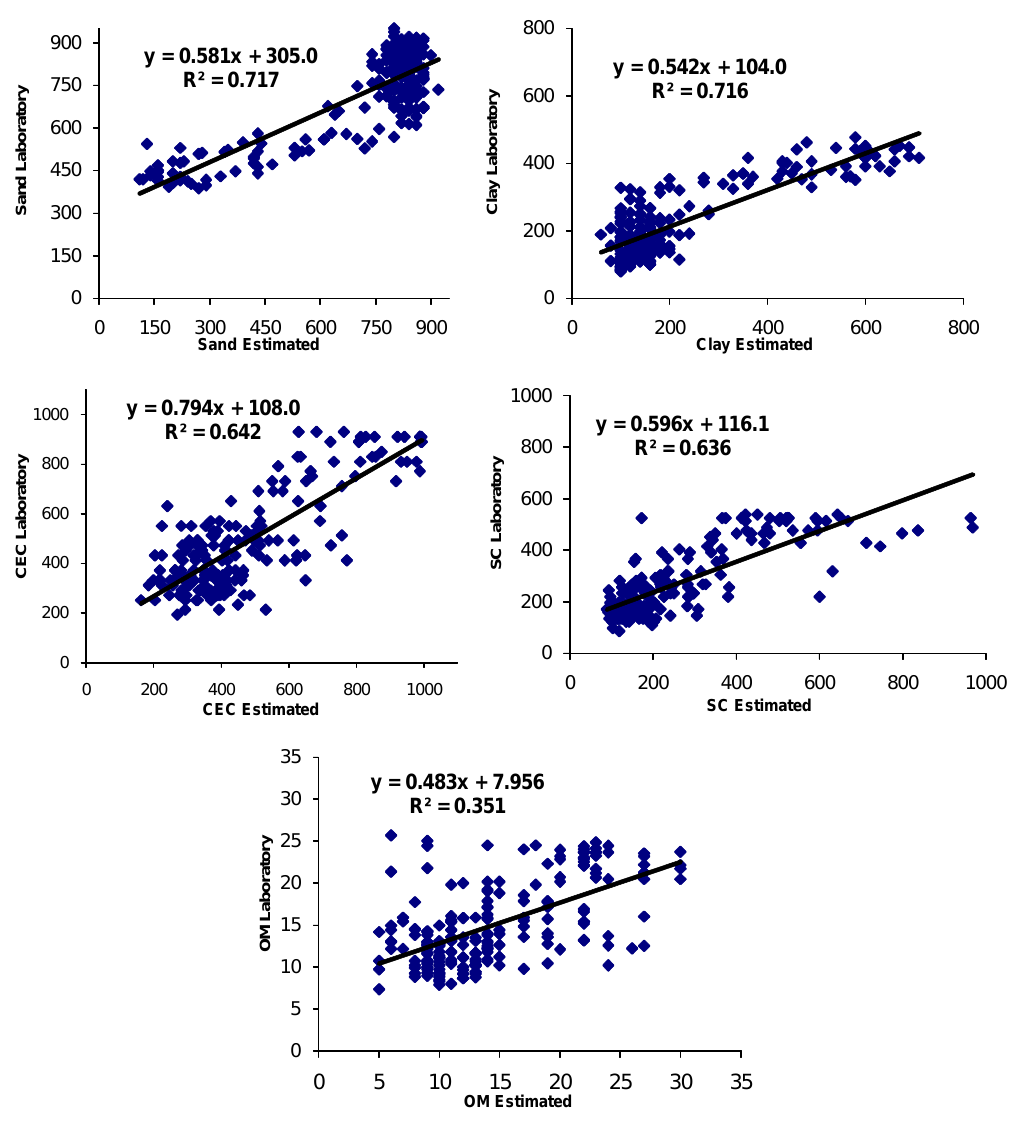
Figure 3. Scatter plot of laboratory determined soil values obtained by routine analysis (Determined Value (Y)) and estimated values obtained with the orbital spectral analysis (Estimated Value